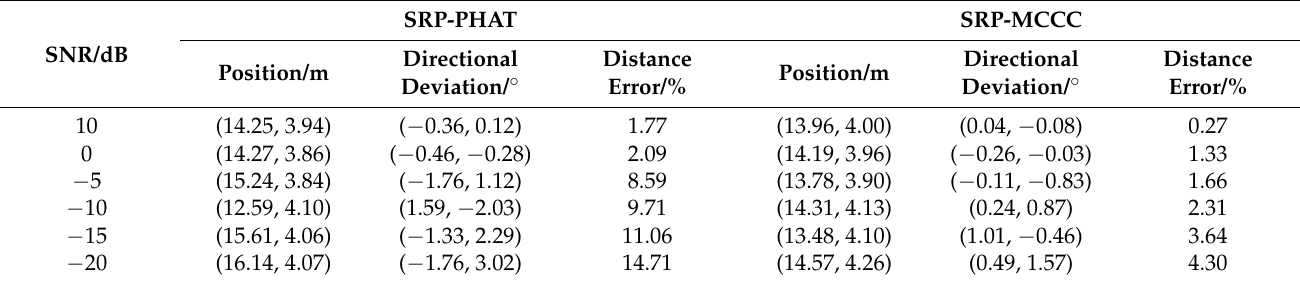
Table 1. Simulation results for different SNR conditions (600 Hz, (14, 4)).